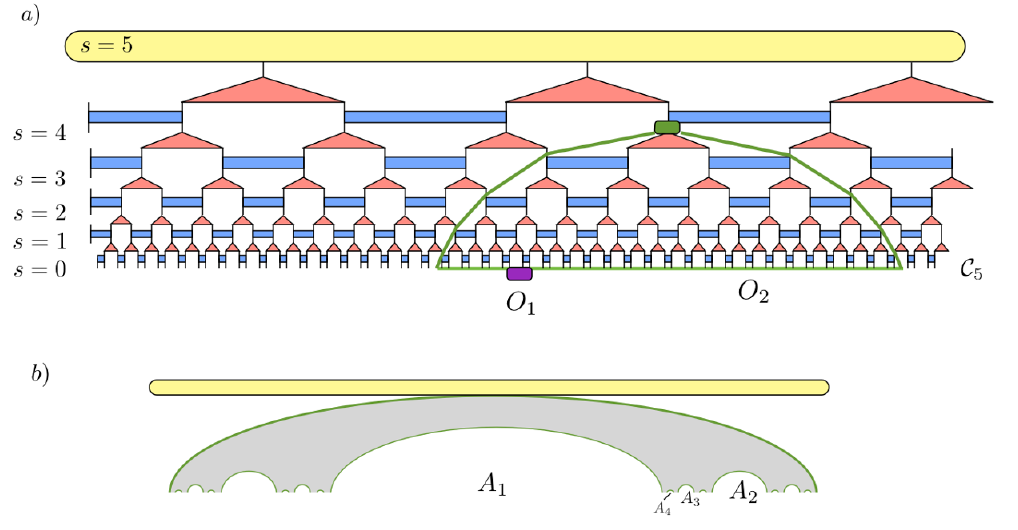
Figure 2 . a) The setup described in section 5.2 where observables O 1 and O 2 act on H 0 . Observable O 2 is a logical operator of C s , in that it maps elements of C s to C s . The Lieb-Robinson type bound of eq. (5.4) tells us how correlated the time evolution of O 1 is with respect to O 2 . b) The minimal correctable region of C s is also the minimal support of a logical operator, which corresponds to the distance of the error correcting code. We see that it takes a cantor-set type form, as already suggested in ref.